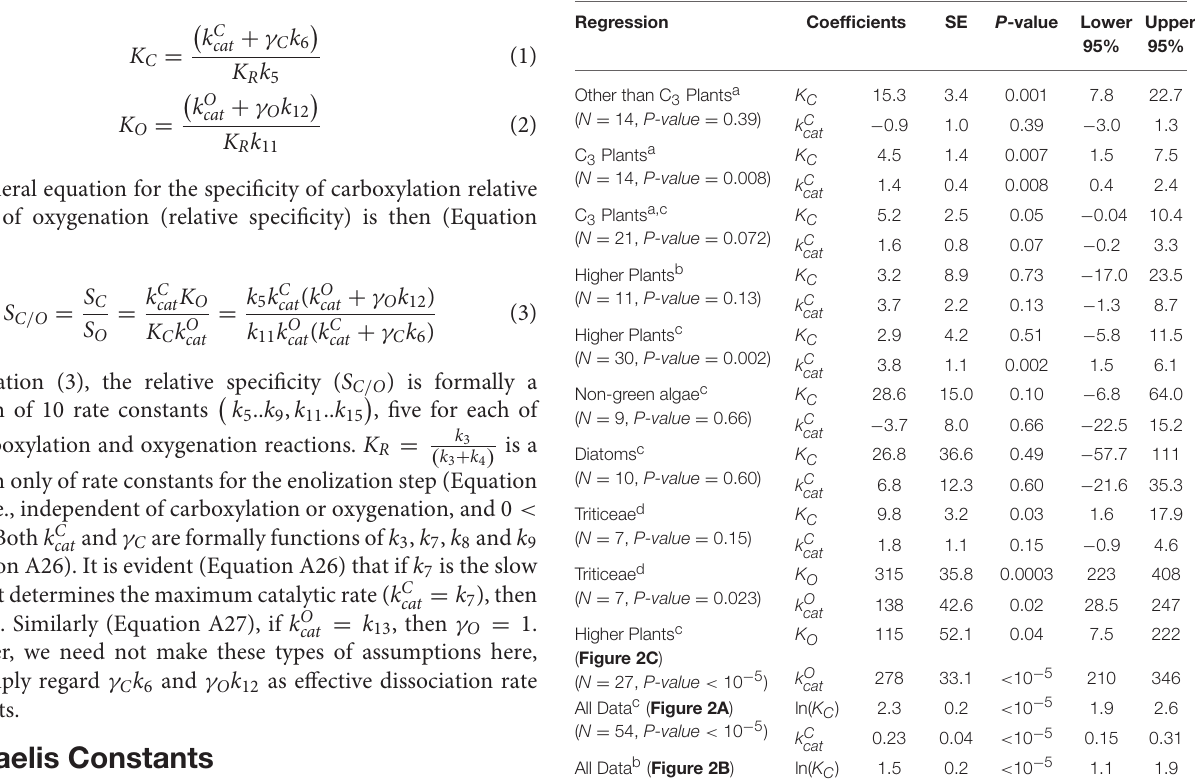
are a 1 b 1 = 2.2 µ M.s and a 1 b 1 = 1.5 µ M.s, respectively.